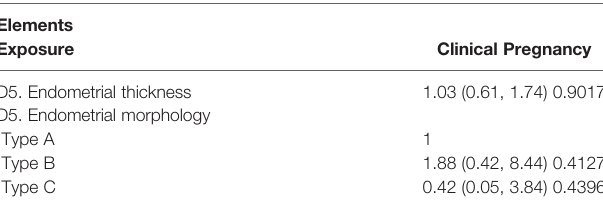
TABLE 5 | One-way logistic regression analysis of endometrial thickness and morphology. Elements